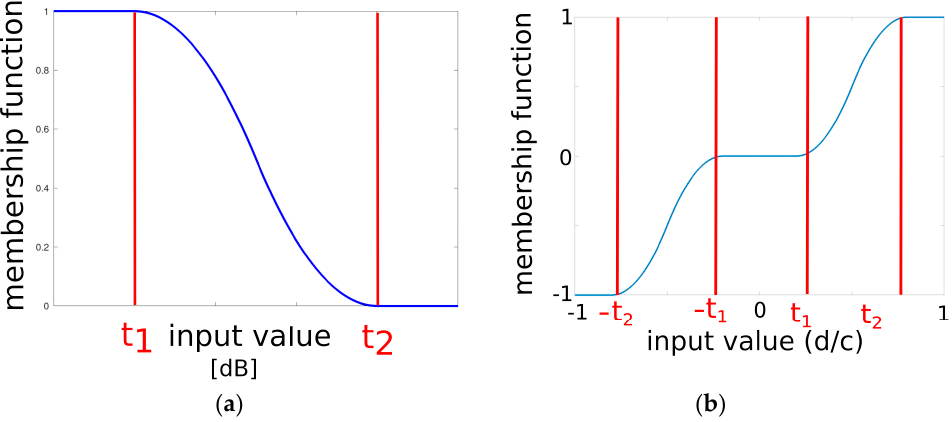
Figure 2. Examples of the “Z” ( a ) and “SS” ( b ) fuzzy functions. The “Z” function is applied within open-water detection (input value is the SAR intensity, thresholds t 1 and t 2 are estimated from data), the “SS” function is applied on the change detection results (input is the change detection statistics: difference divided by the statistically critical difference, thresholds t 1 and t 2 are pre-set). The “SS” function allows the preservation of the sign of the change.